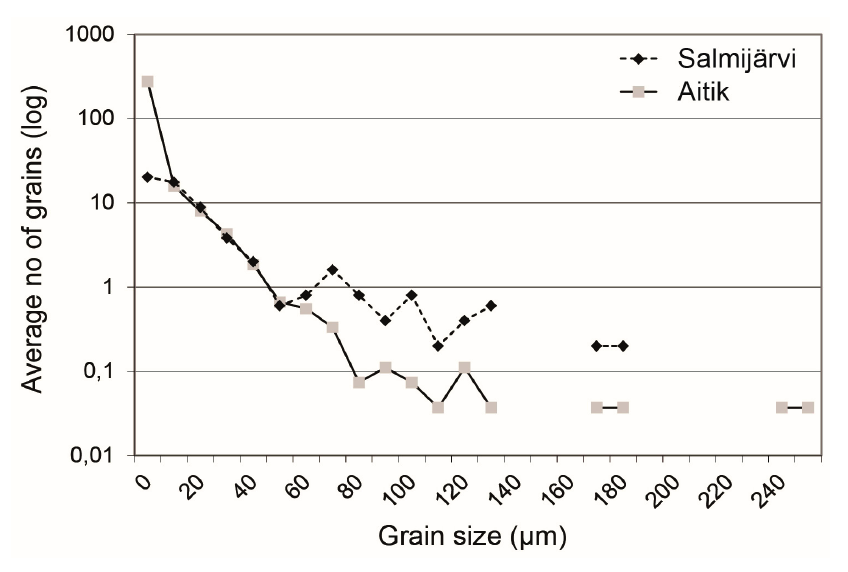
Figure 5. Size distribution diagram for molybdenite grains in the Aitik (27 samples) and Salmijärvi (5 samples) deposits. Circles symbolize one